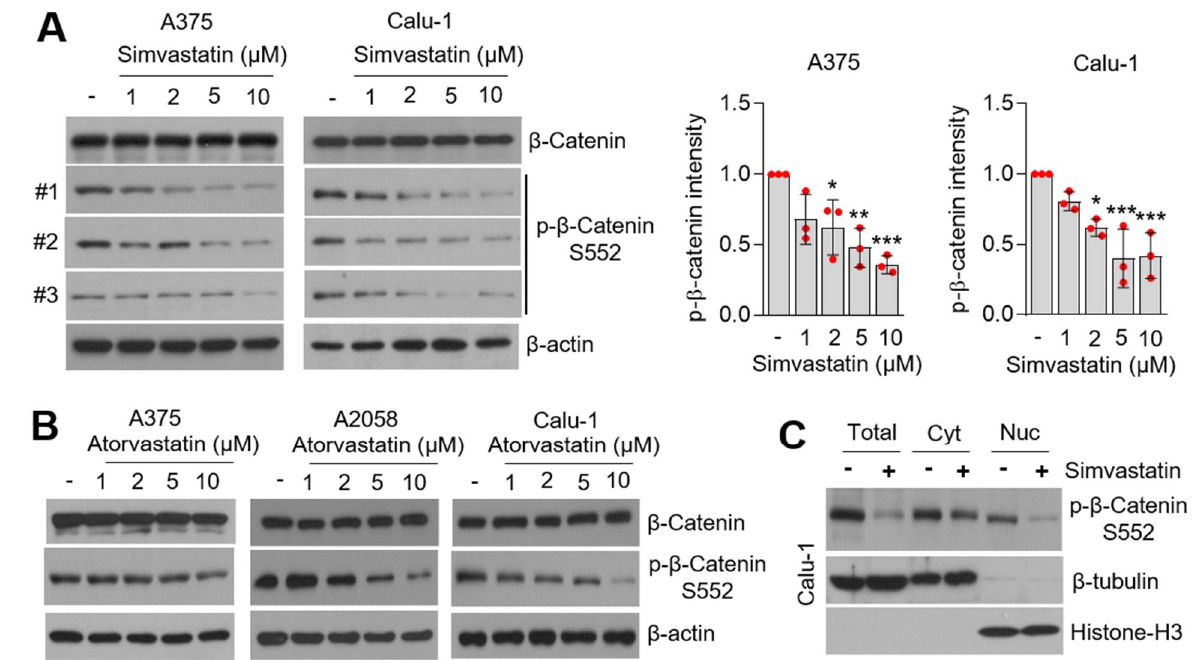
Figure 5. Statins decreased phosphorylation of β-catenin-S552. ( A ) Suppression of β-catenin-S552 phosphorylation in simvastatin-treated lung cancer (Calu-1) and melanoma (A375) cells. Cells were incubated with different concentrations of simvastatin for 6 h. Protein expression was confirmed by using western blotting. Phosphorylated β-catenin protein levels were measured by using western blotting. Phosphorylated β-catenin intensity was quantified and represented by Image J and Graphpad Prism. Each phosphorylated β-catenin-S552 protein level in the statins-treated sample was compared to the vehicle sample. The values represent the mean ± SD from the three independent experiments (#1, #2, and #3) performed. Values represent mean ± SD. * p < 0.05, ** p < 0.01 and *** p < 0.001 by one-way ANOVA, followed by an appropriate post hoc test for the comparison between two experimental groups. ( B ) Atorvastatin suppressed β-catenin-S552 phosphorylation in A375, A2058, and Calu-1 cells. ( C ) Simvastatin decreased nuclear β-catenin. Cells were incubated with DMSO (as a vehicle control) or simvastatin (10 μM) for 8 h and nuclear β-catenin protein levels were measured by using western blotting.